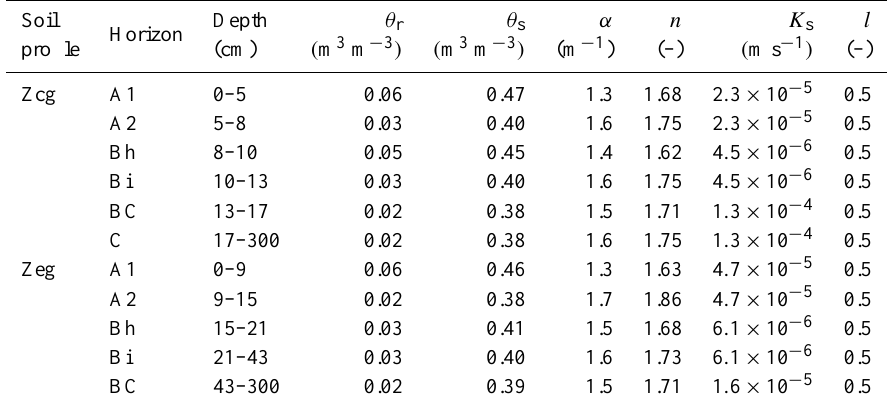
Table 2. Parameters of the van Genuchten-Mualem model for the Zcg and Zeg soil profiles (estimated with pedotransfer function derived by Schaap et al., 1999). θ r and θ s are residual and saturated water content, respectively, K s is saturated hydraulic conductivity, and α , n , and l are curve shape parameters.